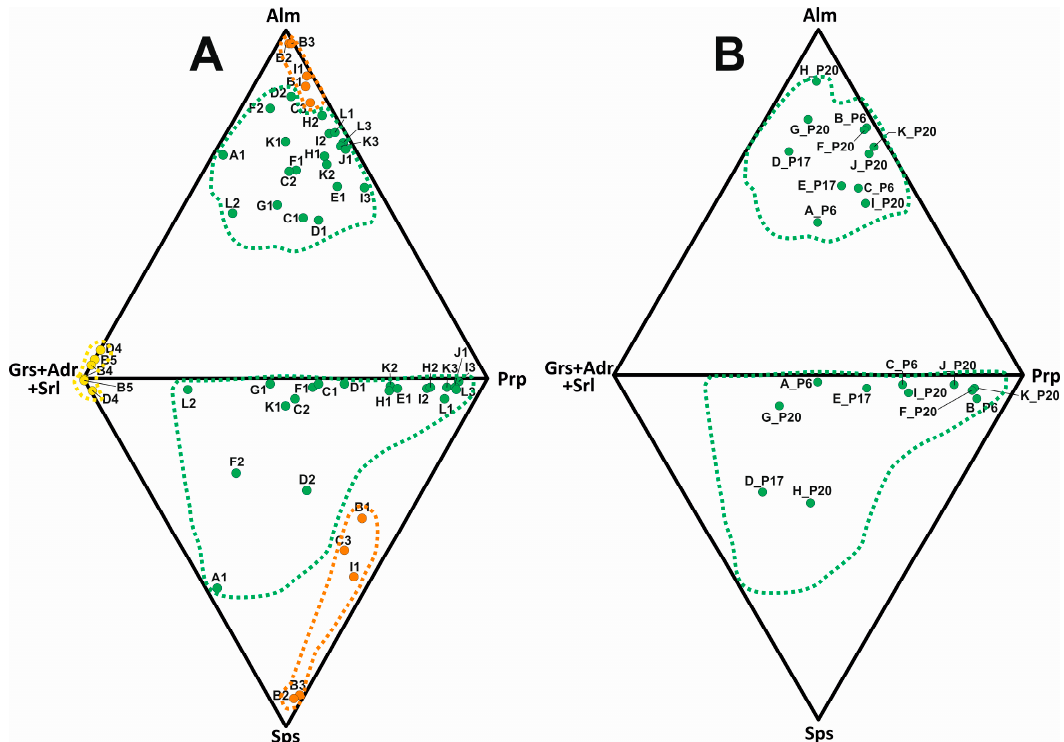
Figure 20. ( A ) . Northern Portuguese continental shelf. Orange dots and correspondent surrounding area indicate garnets sourced from granites. Green dots and correspondent surrounding area indicate garnets sourced from metamorphic rocks of amphibolitic and granulitic facies. Yellow dots and correspondent surrounding area represent garnets sourced from calc-silicate skarns. ( B ) Porto canyon area. Green dots indicate garnets sourced from metamorphic rocks of amphibolitic and granulitic facies.